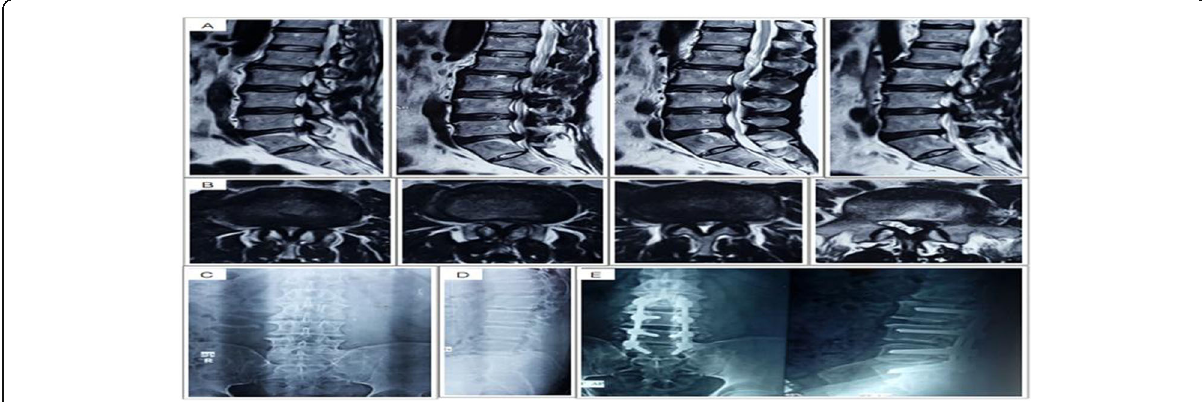
Fig. 1 Sagittal and axial T2WI MRI images ( a and b ) showed multiple level discogenic with ligamentum and bony stenosis. Preoperative radiographs [AP and lateral views] are normal with no spinal instability ( c and d ). PO radiographs [AP and lateral views] showed 4 levels of conventional laminectomy with posterolateral fusion ( e